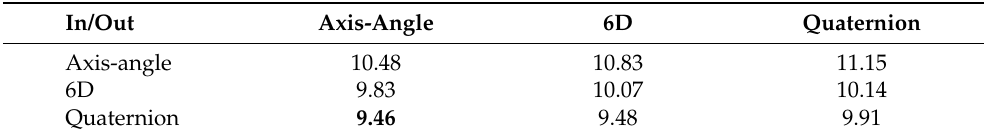
Table 2. Ablation results for GMR input and output representations on Human3.6M. The row and the column correspond to the input local pose and the output orientation motion in GMR, respectively. Numbers denote the VME. The best results are shown in bold.